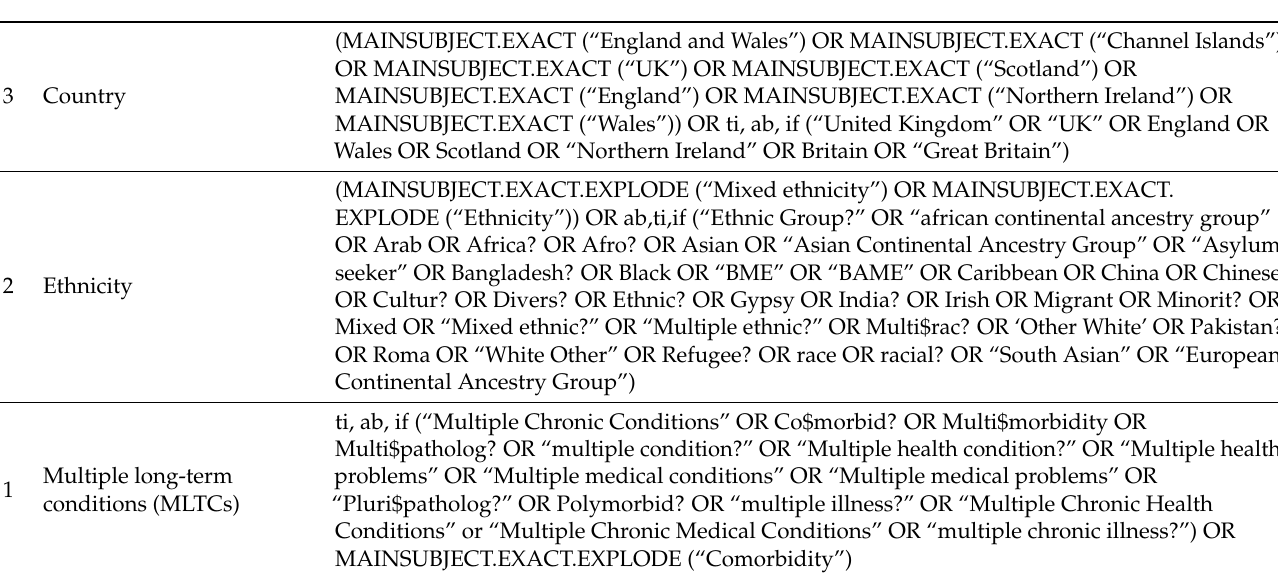
Continental Ancestry